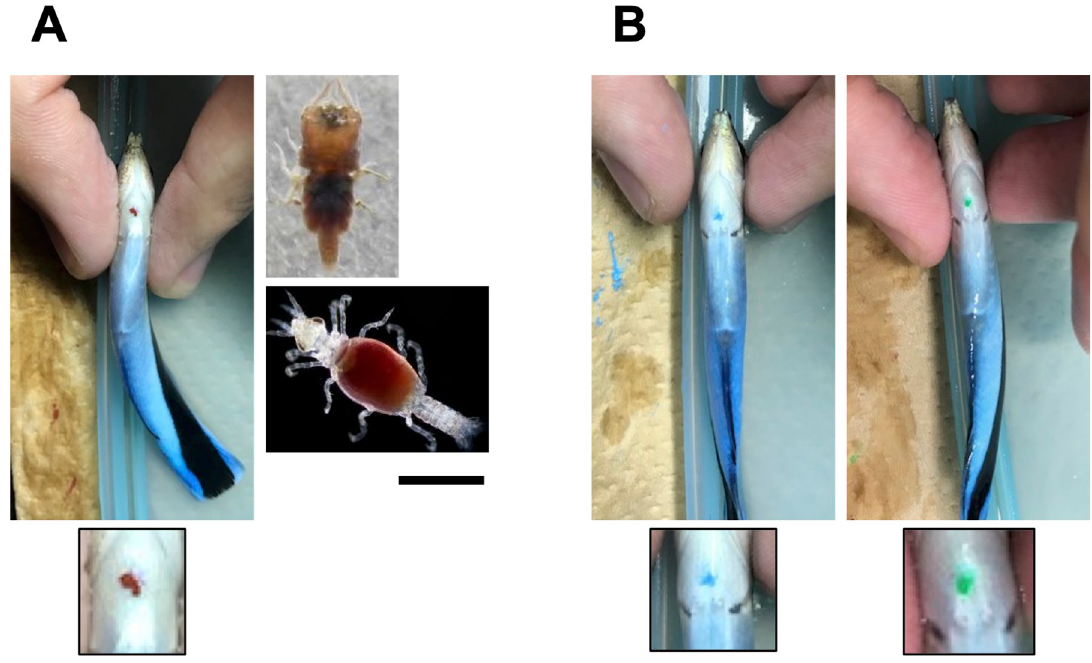
Fig 1. Ecologically relevant color mark (brown) on the throat of cleaner fish and ectoparasite (sea stag) (A) . Bar is 1 mm. Meaningless color mark (green and blue) on the throat (B) . These cleaner fish are just after mark injection and are still in the anesthetized condition.